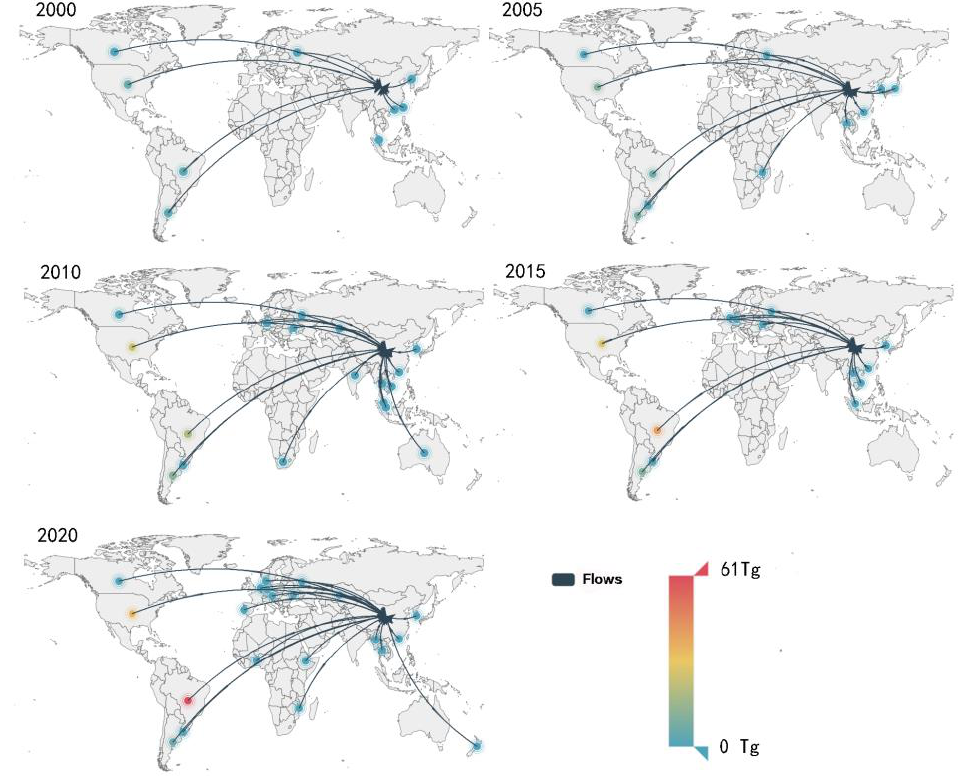
Figure 4. The main trade flows of China’s soybean imports in 2000, 2005, 2010, 2015, and 2020 (data source: FAO). Note: the figure only shows the trade flows greater than 10 tons.